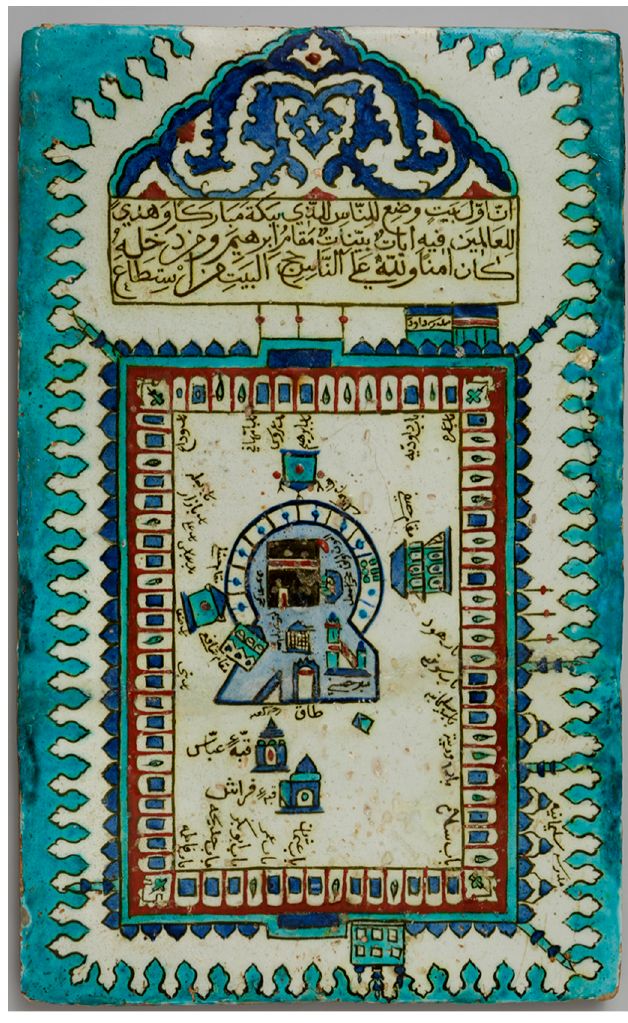
Figure 8 . A circa 1640 tile depiction of Mecca with the Ka’ba at the center, formerly set in the qibla wall of a mosque. The relationship between the tile’s visual vocabulary and that of the pilgrimage scroll is immediately evident. Aga Khan Museum, AKM58.